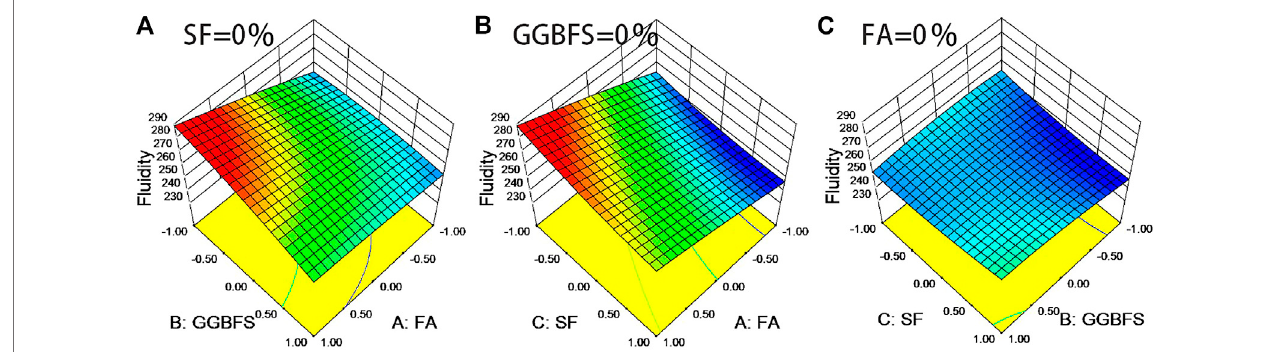
FIGURE 8 | The combined effect of SCMs on fl uidity of nano-silica modi fi ed cement-based paste.